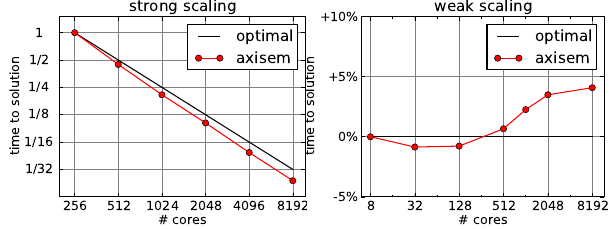
Fig. 6. Scalability of AxiSEM on a Cray XE6 at CSCS (Switzer- Figure 6. Scalability of AxiSEM on a Cray XE6 at CSCS (Switzer- land). Left: Strong scaling, i.e. fixed global problem size (8 Million land). Left: Strong scaling, i.e., fixed global problem size (8 Million 2D elements) as a function of the number of used cores commu- 2-D elements) as a function of the number of used cores commu- nicating via the message-passing interface, for 12000 time steps. nicating via the message-passing interface, for 12000 time steps. AxiSEM scales super-optimal, which is mostly due to the more ef- AxiSEM scales super-optimally, which is mostly due to the more ficient usage of run-time memory if less memory is used per core. efficient usage of run-time memory if less memory is used per core. Right: Weak scaling, i.e. fixed problem size per core (1000 ele- Right: Weak scaling, i.e., fixed problem size per core (1000 ele- ments) for 1000 time steps. The desired constant time-to-solution ments) for 1000 time steps. The desired constant time-to-solution is is exceeded by 4% for > 8000 cores in which case communication exceeded by 4% for > 8000 cores, in which case communication is is not entirely hidden behind the computation of the stiffness terms. not entirely hidden behind the computation of the stiffness